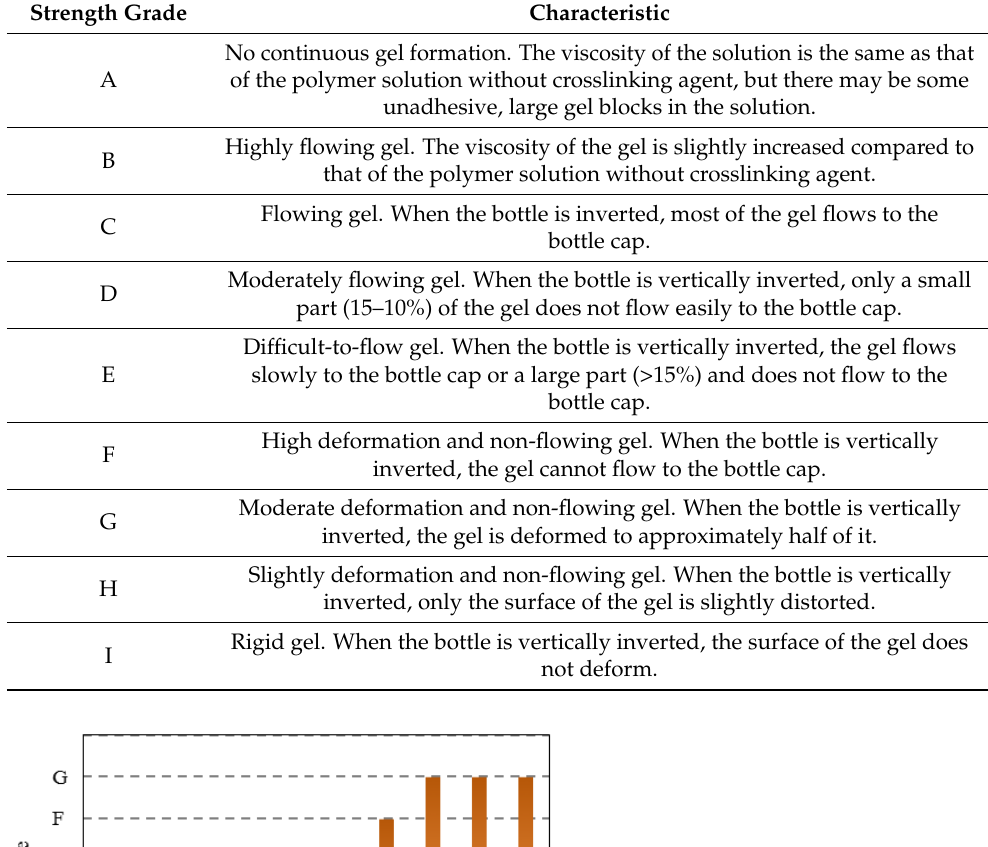
Table 3. Gel strength grade standard.